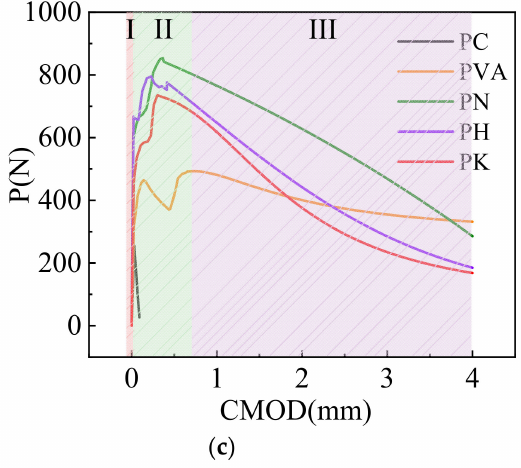
Figure 4. Load-crack mouth opening displacement curves of cemented soil with fiber contents of 0.25% ( a ), 0.5% ( b ) and 1% ( c ) before and after modification.